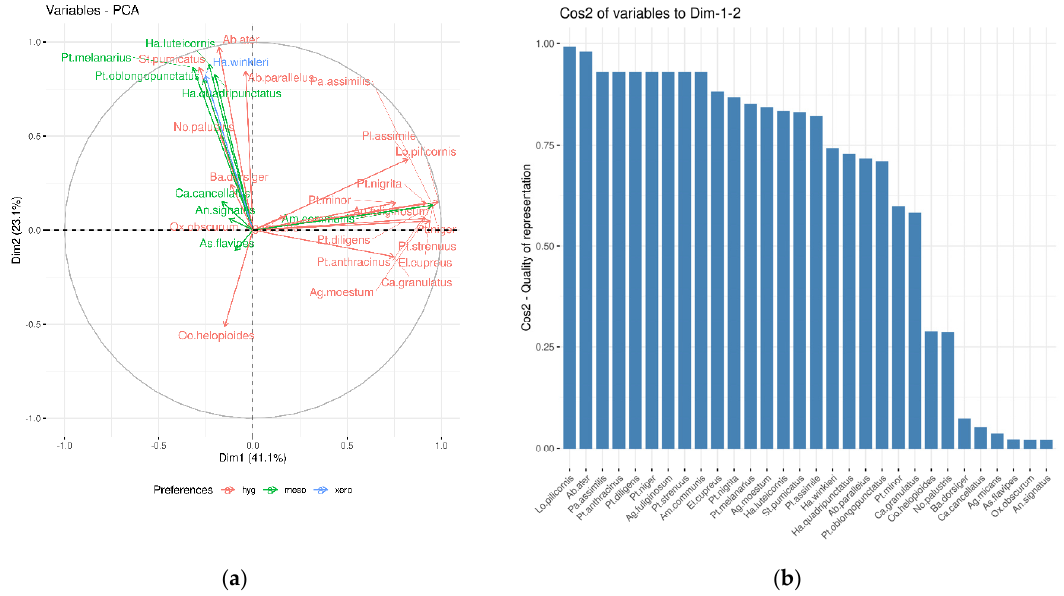
Figure 5. ( a ) PCA graph of standardized abundances of 30 ground beetles species in ravine habitats in the wet period. ( b ) Cos2 plot for ground beetles species in the wet period. Abbreviations: hyg—hygrophilous, meso—mesophilous and xero—xerophilous species. Codes of carabid species are given in Table 1.